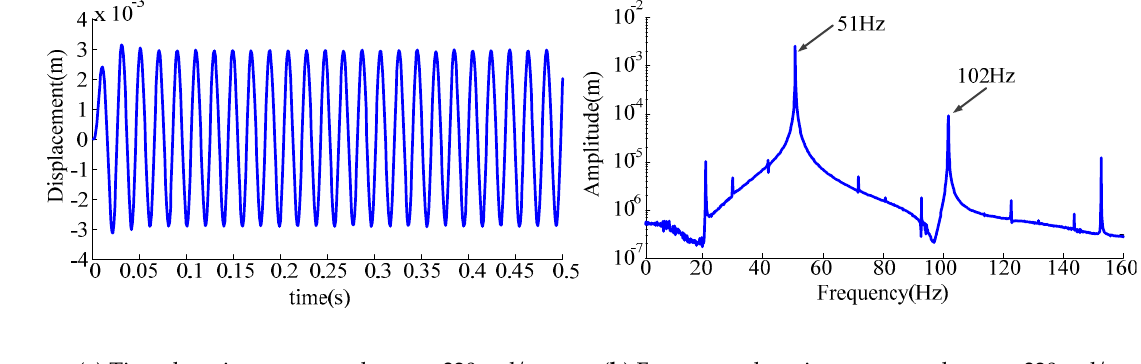
Figure 4. Response of rotor-bearing system under critical speed condition.